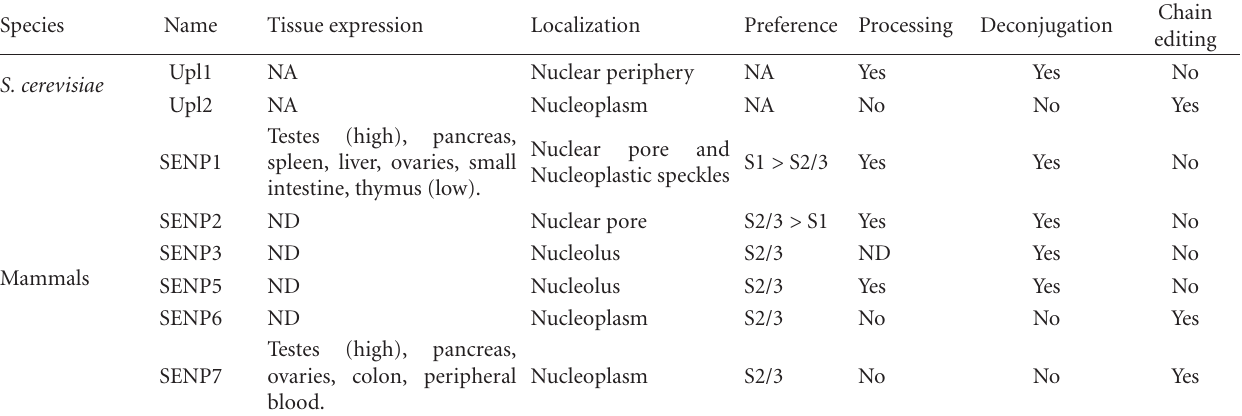
Table 1: SUMO/Sentrin specific proteases. SUSPs/SENPs implications and functions. Adapted from Wilkinson and Henley, 2010 [3]. Species Name